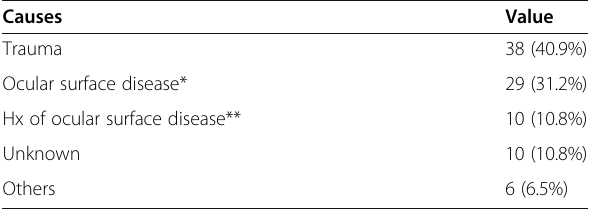
Table 2 Causes of pediatric keratitis. LSCD: Limbal stem cell deficiency, HSV: Herpes simplex virus Causes